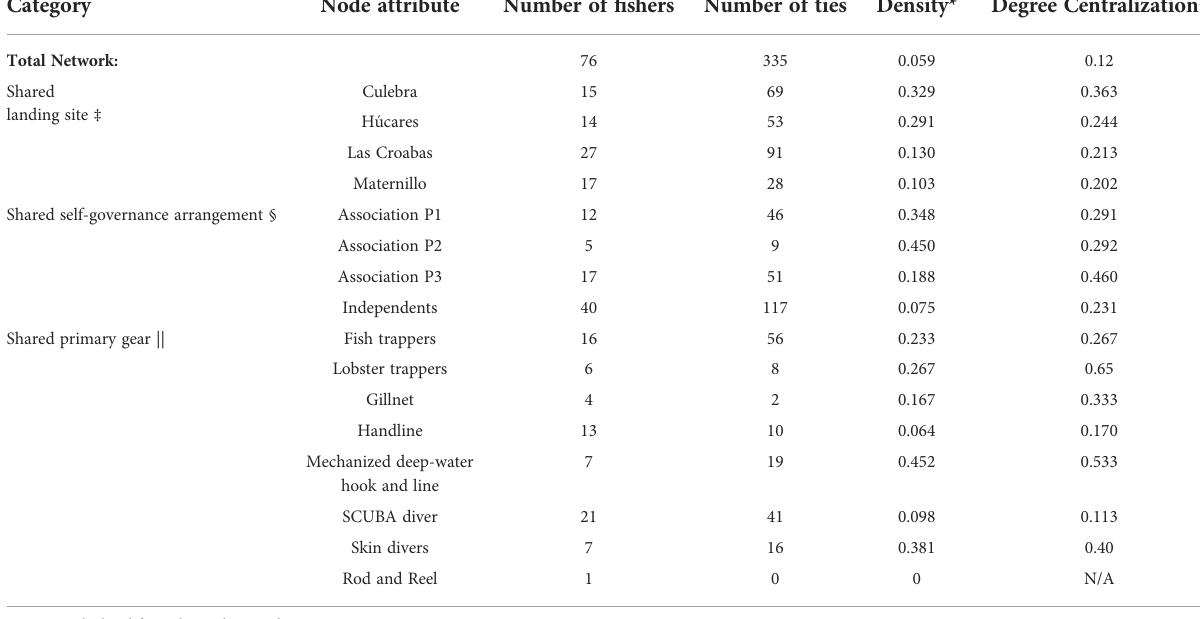
TABLE 4 Descriptive metrics for the information-sharing network, disaggregated across homophily effects, indicative of different drivers of social cohesion.